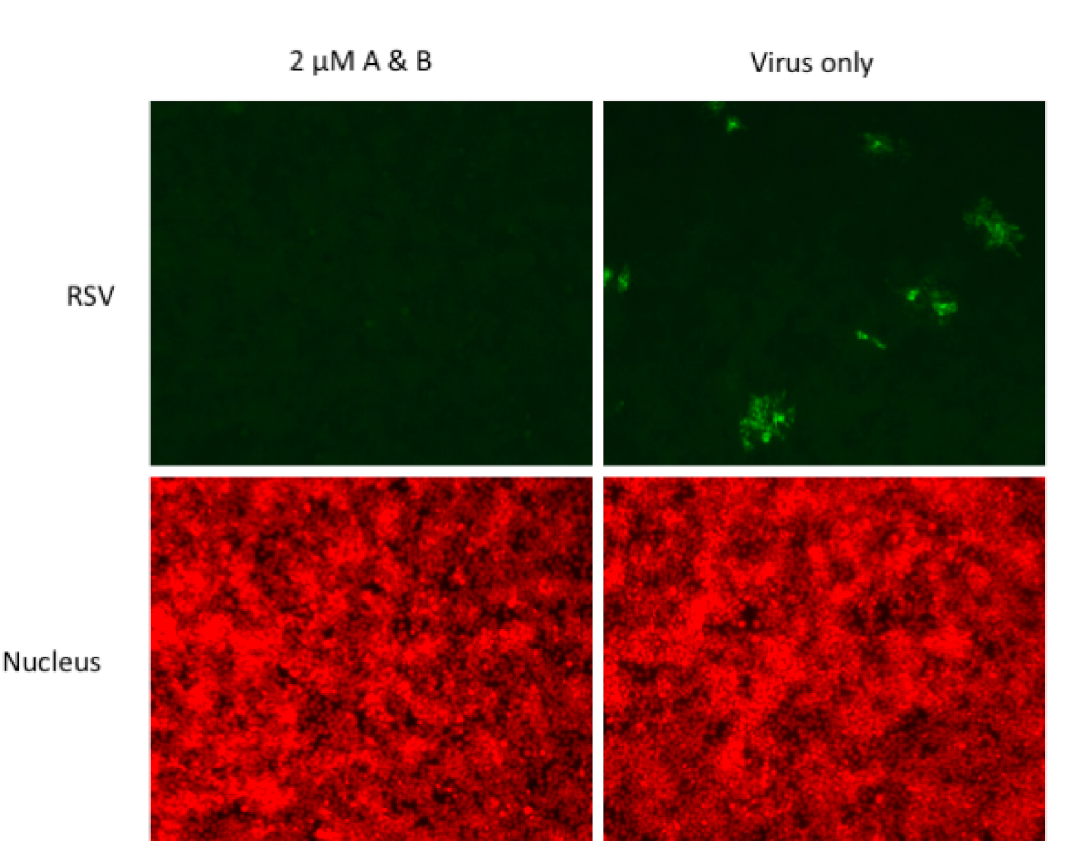
Figure 6. Fluorescence photographs from representative wells of HEp-2 cells immunostained for RSV and counterstained for nucleus as a control. Note the almost complete absence of RSV staining in the well treated with peptide A and